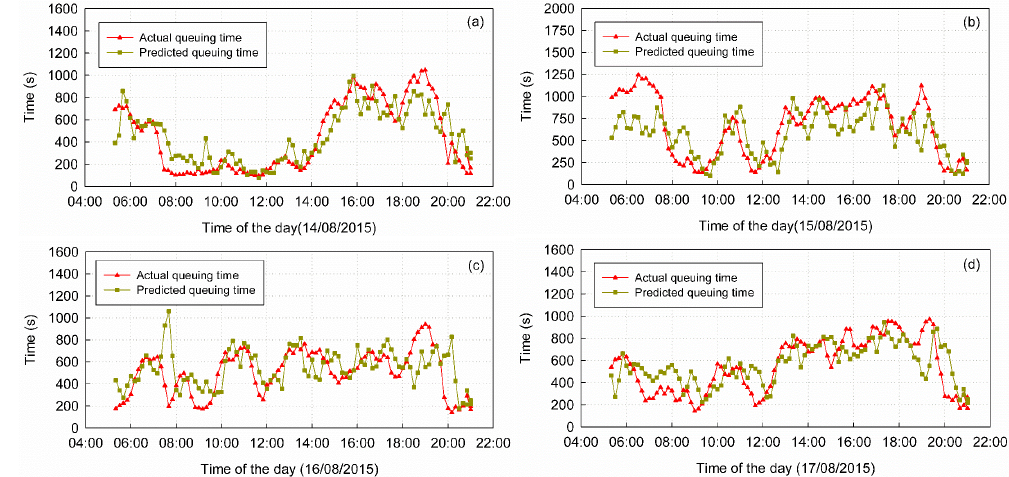
Figure 9. Comparison of the predicted and actual queuing times. ( a ) Comparison of the predicted and actual queuing times on 14 August; ( b ) Comparison of the predicted and actual queuing times on 15 August; ( c ) Comparison of the predicted and actual queuing times on 16 August; ( d ) Comparison of the predicted and actual queuing times on 17 August.